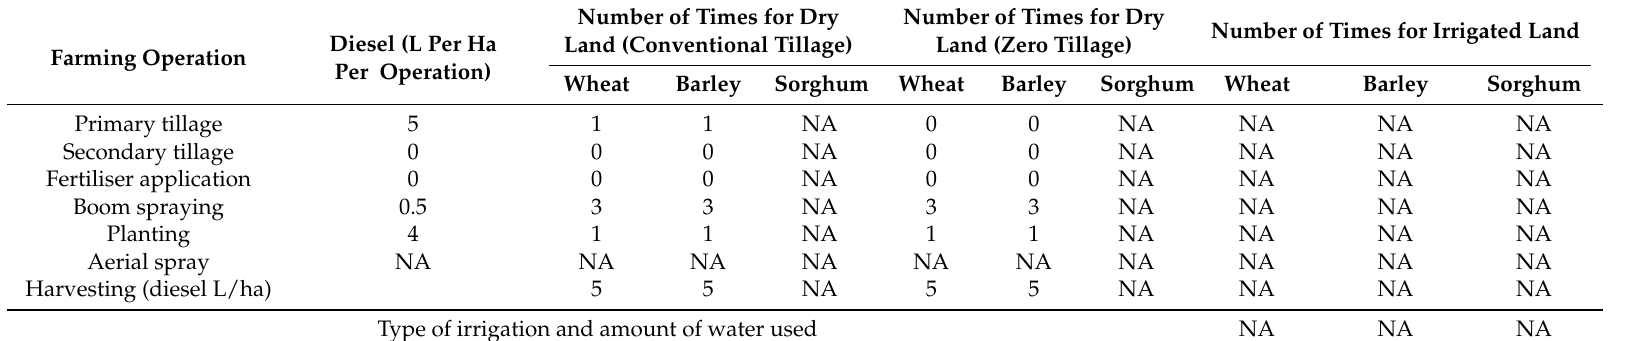
Table 4. On-farm operation data for high value grain crops in Western Grain Region (Western